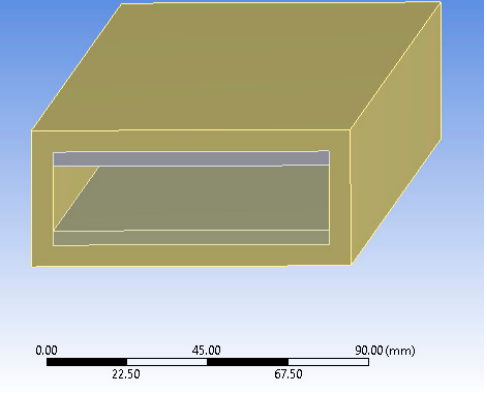
Figure 5. The cross section of one of the analyzed columns (placed on its side).